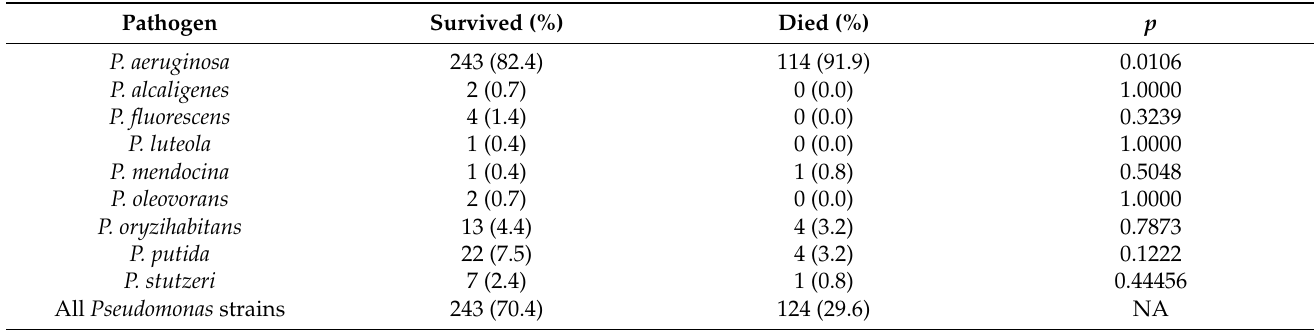
Table 3. Microbiology of Pseudomonas strains isolated from patients’ blood cultures, and patients’ outcome at 30 days after the occurrence of bacteremia.